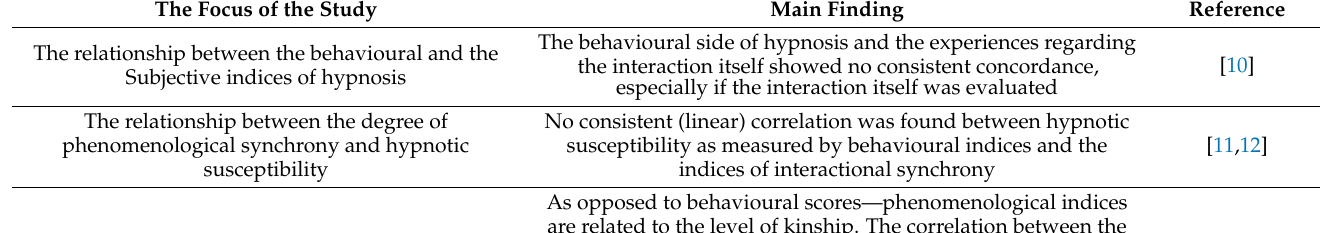
Table 1. Our main studies in phenomenology of hypnosis